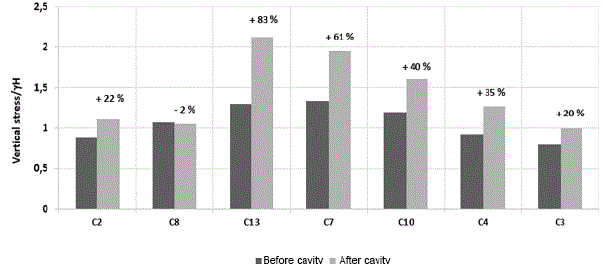
Figure 4. Initial and final stress at the base of the soil layer in the case of the granular soil (Fontainebleau